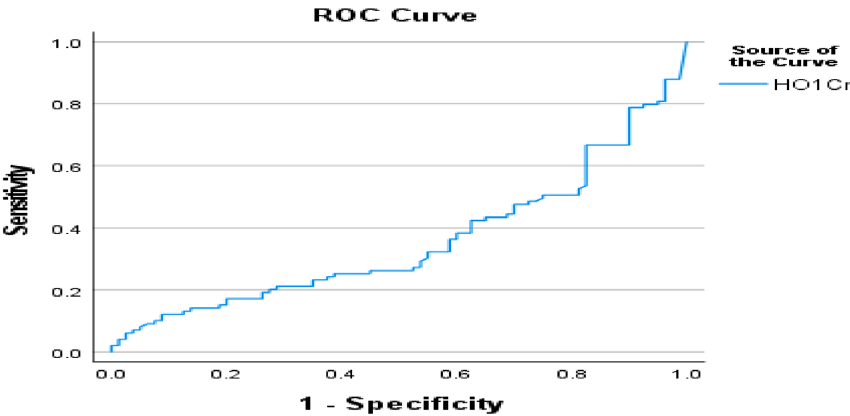
Figure 3. The crude AUC of the ROC curve of urinary HO-1 for predicting early tubular injury in diabetic patients.